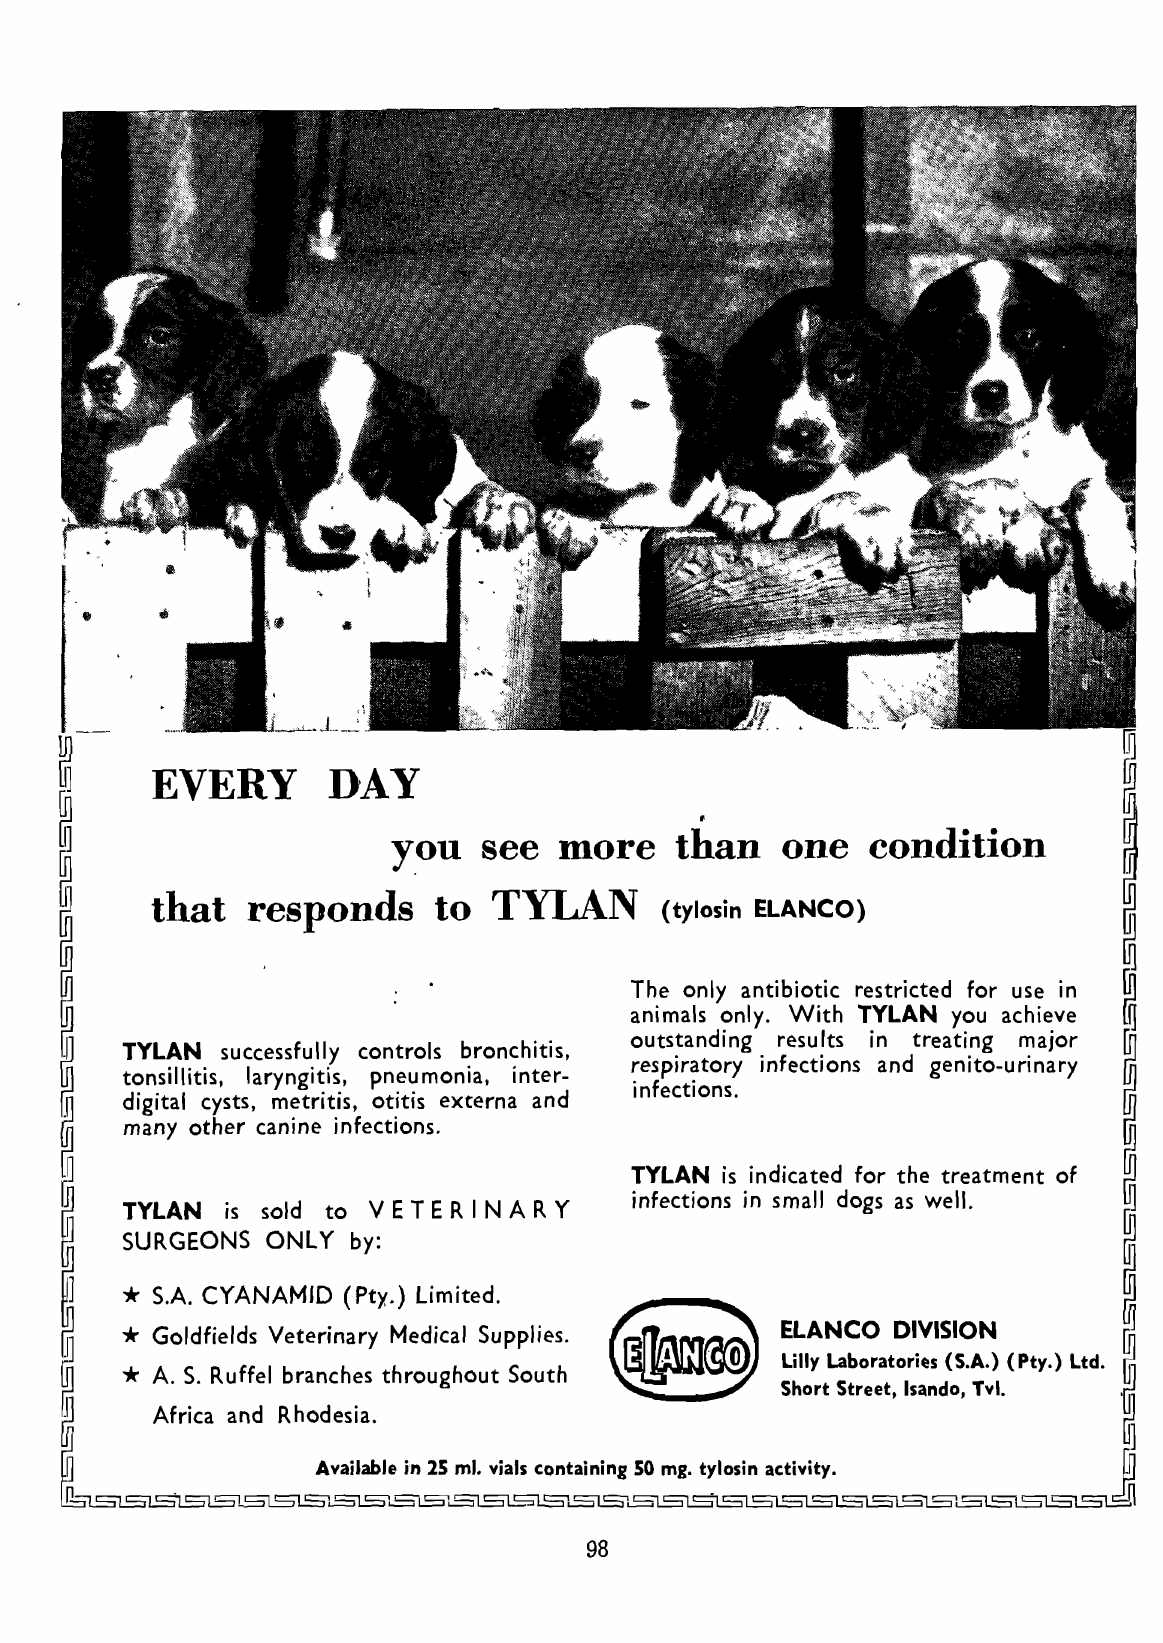
(tylosin ELANCO) The only antibiotic restricted for use in animals only. With TYLAN you achieve outstanding results in treating major ~espjr~tory infections and genito-u rinary mfectlons. TYLAN is indicated for the treatment of infections in small dogs as well. @~ ~ ELANCO OIVlSION ~~ Lilly Laboratories (S.A.) (Pty.) Ltd. Short Street. Isando,